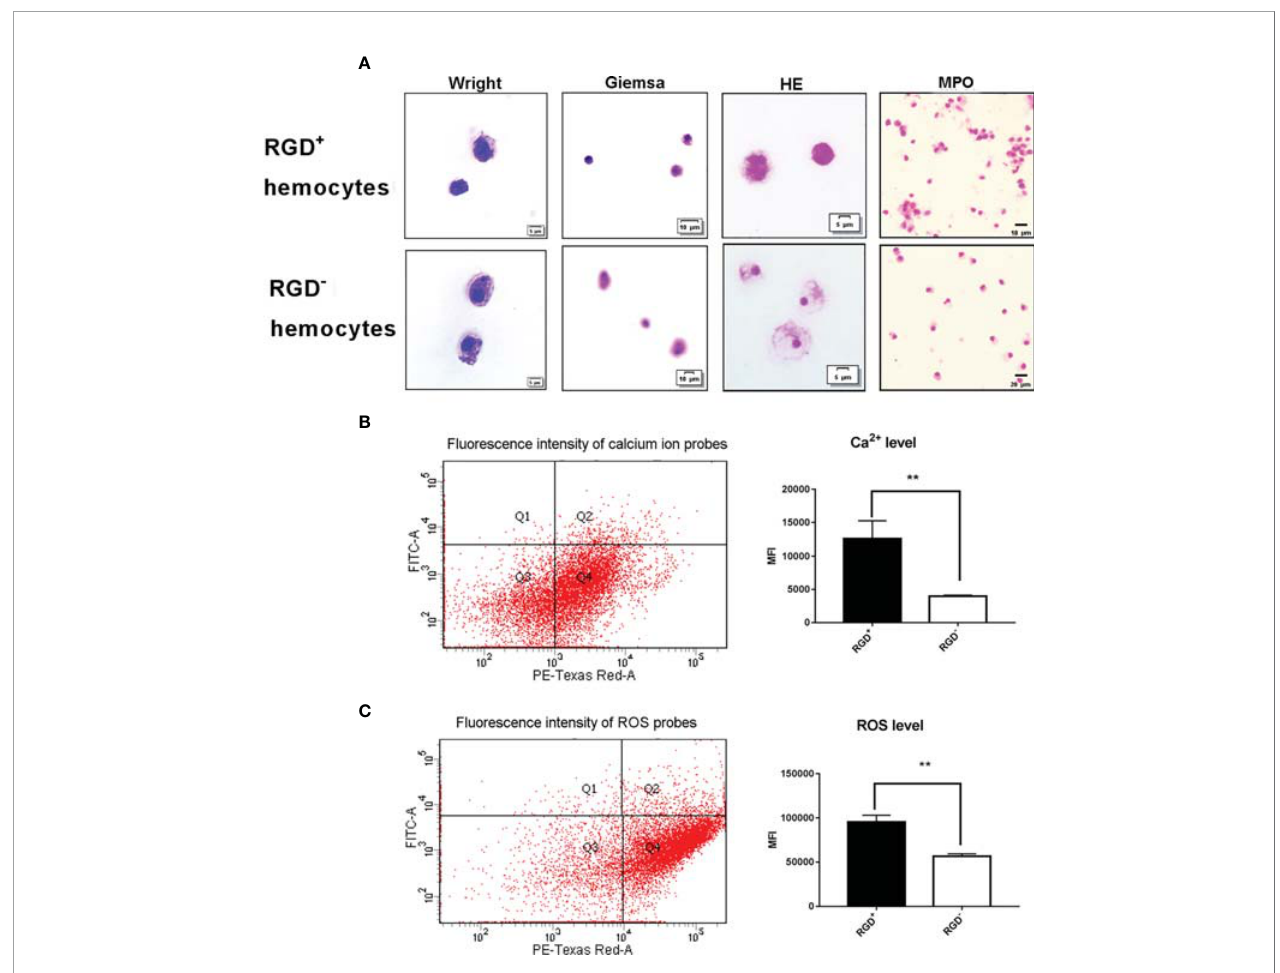
FIGURE 3 | Morphological and cytochemical features of C. gigas RGD + hemocytes. (A) The cytochemical staining of resting RGD + /RGD - hemocytes. Resting RGD + /RGD - hemocytes were stained for Wright, Giemsa, HE, and MPO. The upper panel and lower panel show cytochemical staining of sorted resting RGD + hemocytes and RGD - hemocytes, respectively. The differences in (B) intracellular Ca 2+ and (C) ROS levels between resting RGD + and RGD - hemocytes. The double asterisk (**) stands for statistical signi fi cance at p <